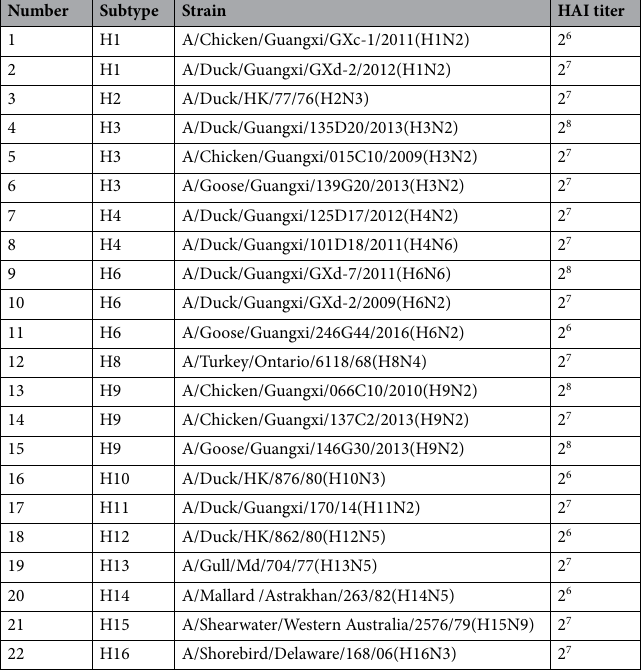
Table 3. List of the primary strains used in the preparation of antisera of HAI